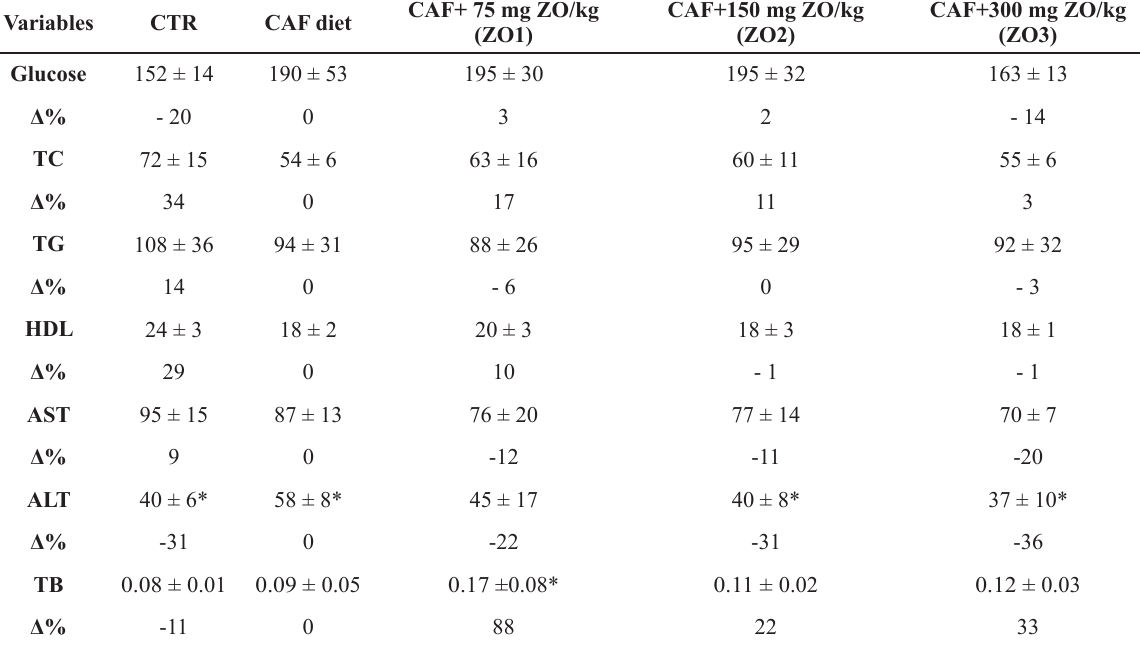
Circulating concentrations of glucose and lipidic and hepatic markers (mg/dL) in the different experimental groups.